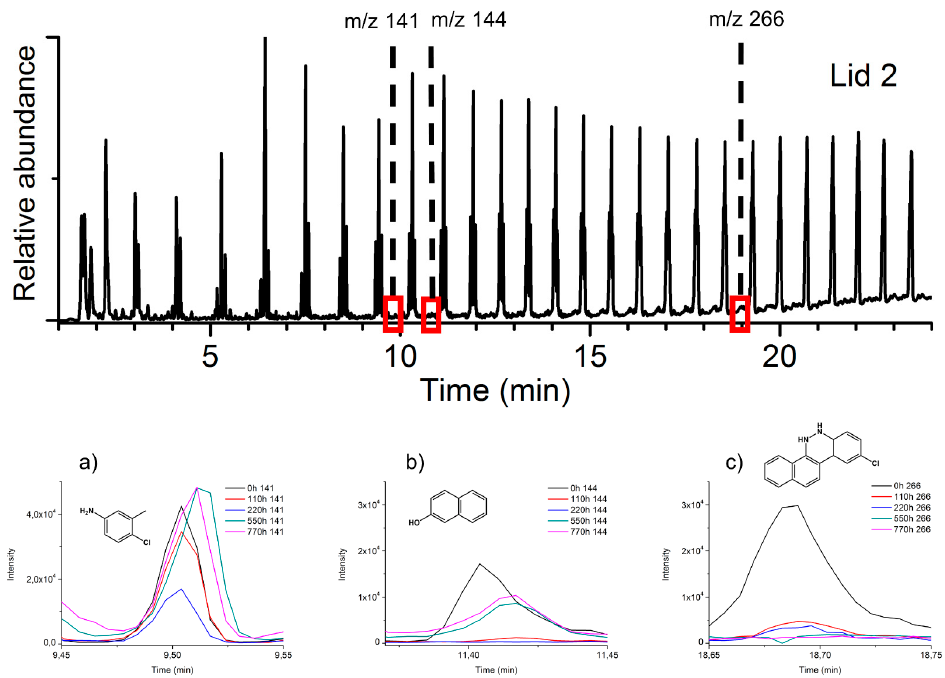
Figure 9. Normalized pyrogram of lid 2 at 0 h and related extracted ions (base peaks) of the main pyrolysis products of the pigment PR 53:1, M w 141 ( a ), M w 144 ( b ), and M w 266 ( c ), during the several aging steps (0–110–220–550–770 h).